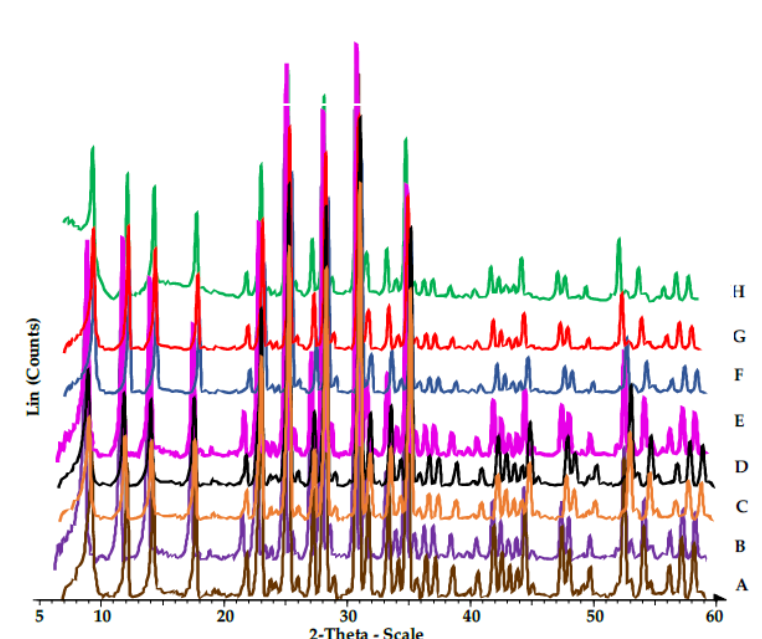
Figure 1. XRD diffractograms of ( A ) NaY, ( B ) Ga-NaY, ( C ) 0.02BaGa-NaY, ( D ) MgGa-NaY, ( E ) CaGa-NaY, ( F ) SrGa-NaY, ( G ) BaGa-NaY, ( H ) 0.08BaGa-NaY.